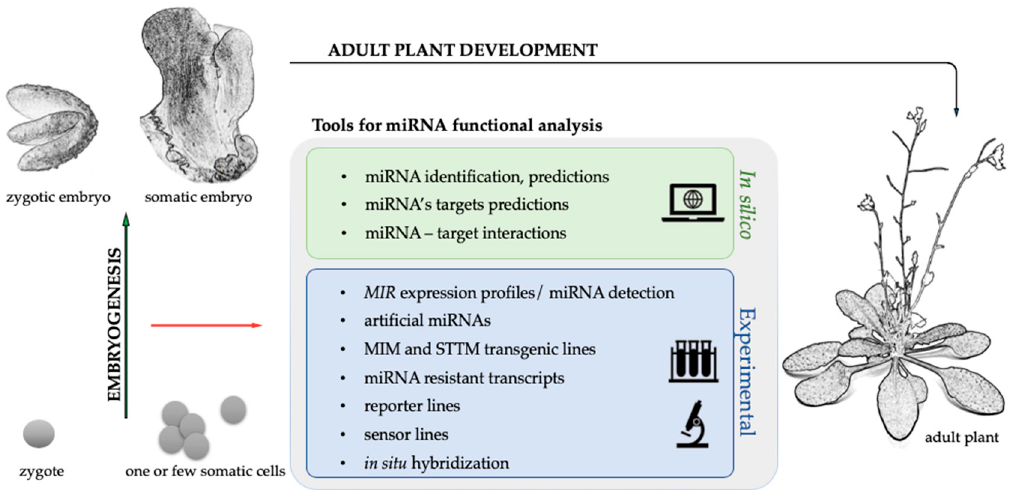
Figure 2. The toolbox dedicated for the functional analysis of plant miRNAs during embryogenesis using the in silico and experimental approaches.